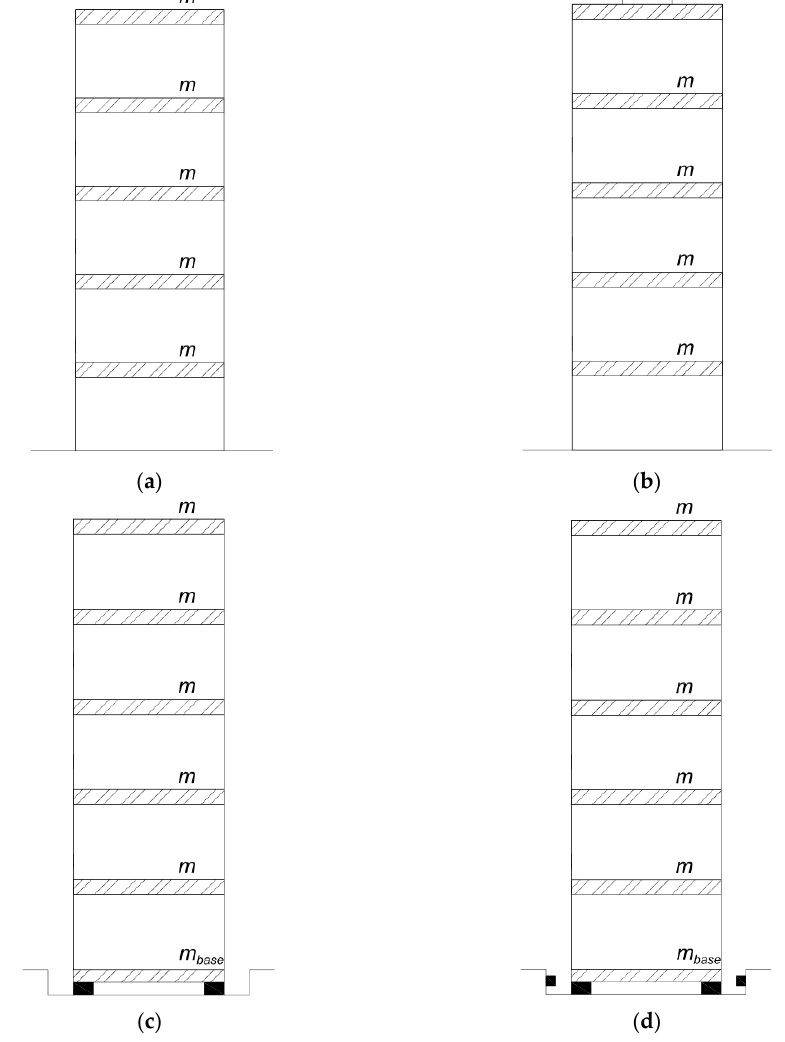
Figure 1. Schematic model of the five-story building under different configurations: ( a ) fixed supports; ( b ) fixed supports with a Tuned Mass Damper (TMD); ( c ) isolated base and ( d ) isolated base with rubber bumpers. Table 1. Ground motion records used in the analysis.